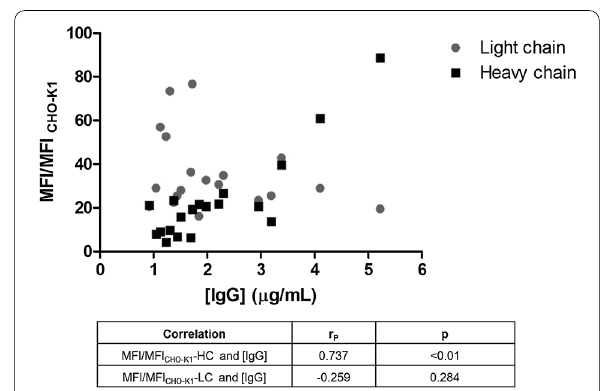
Fig. 5 Correlation between intracellular antibody polypeptides content and concentration of IgG in cell culture supernatants. Cell mini‑pools were seeded in 24 wells plate in CP‑CHO‑CB5‑FBS medium. After 10 days concentration of IgG in cell culture supernatants was measured by ELISA. Intracellular HC and LC polypeptides of ethanol fixed cells were assessed by flow cytometry. MFI/MFI CHO‑K1 : mean fluorescence intensity of trastuzumab‑expressing cells compared to the mean fluorescence intensity of CHO‑K1 wild type cells ratio. The correlation between variables was computed using a parametric test based on Pearson